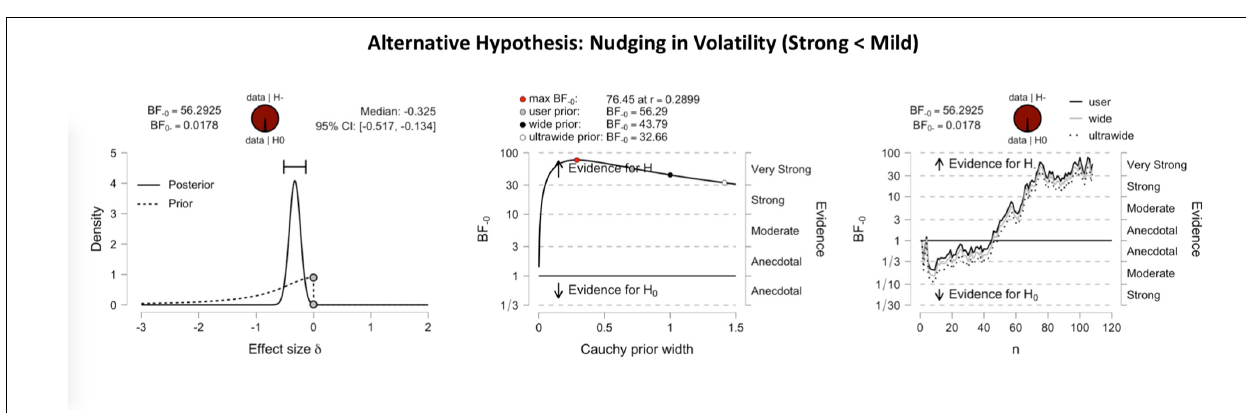
FIGURE 4 | Inferential plots of Bayesian paired-samples t -test, with nudging in volatility as the alternative hypothesis. Same format as in Figure 3 . With a Bayes factor BF - 0 of 56.29, the evidence appears very strong in favor of the nudging-in-volatility hypothesis as compared to the null